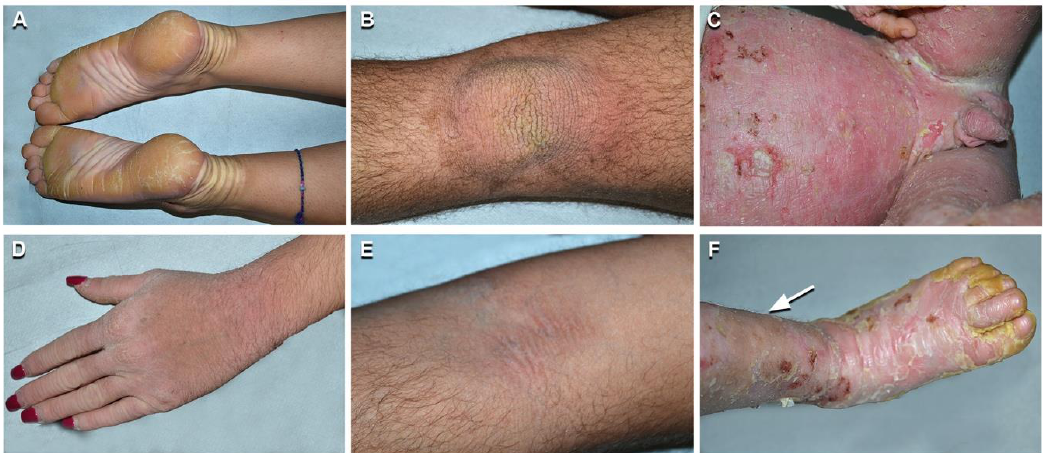
Figure 2. Phenotypic spectrum of epidermolytic ichthyosis (EI). Mild EI phenotype in two siblings (patients n . 1 and 2 of Table 1): yellowish plantar keratoderma with erythematous halo, left hand dorsum hyperkeratosis and hypertrichosis on the upper left limb in the sister aged 19 years ( n . 2 of Table 1) ( A,D ); yellowish verrucous hyperkeratosis of the left knee and mild linear hyperkeratosis in the left antecubital fossa in the brother aged 21 ( n . 1 of Table 1) ( B,E ). Severe and diffuse erythroderma, with erosions, crusts, and yellowish thick hyperkeratosis in a 3-year-old child ( C,F ) ( n . 13 of Table 1). Note leg hypertrichosis in F (arrow).